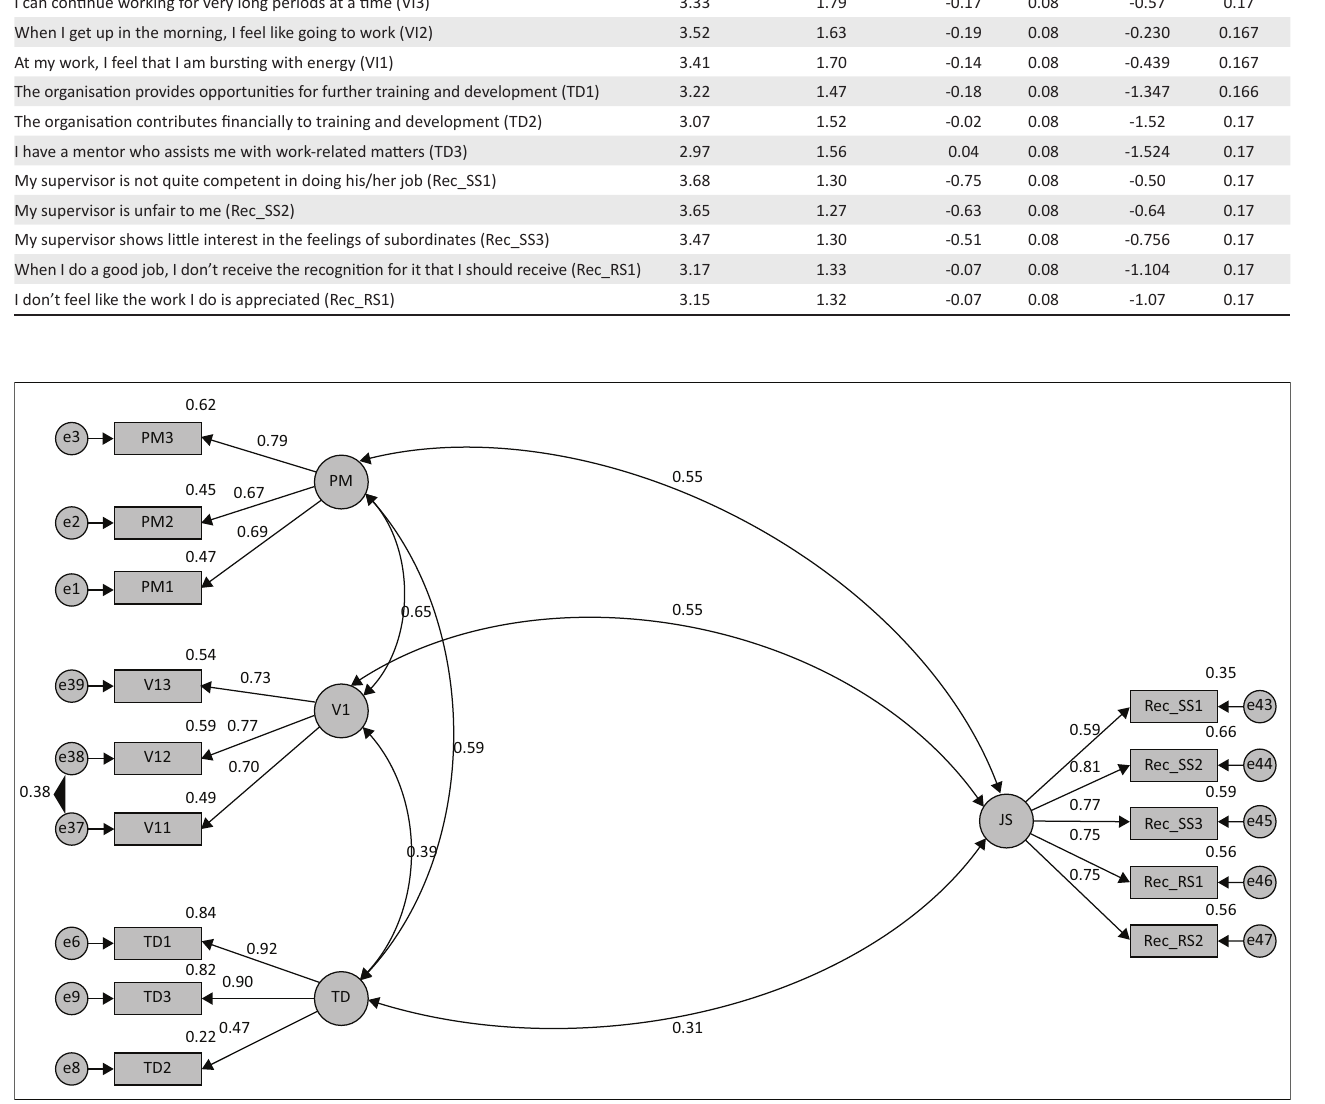
FIGURE 2: Measurement model. PM, performance management; VI, vigour; TD, training and development; JS, job